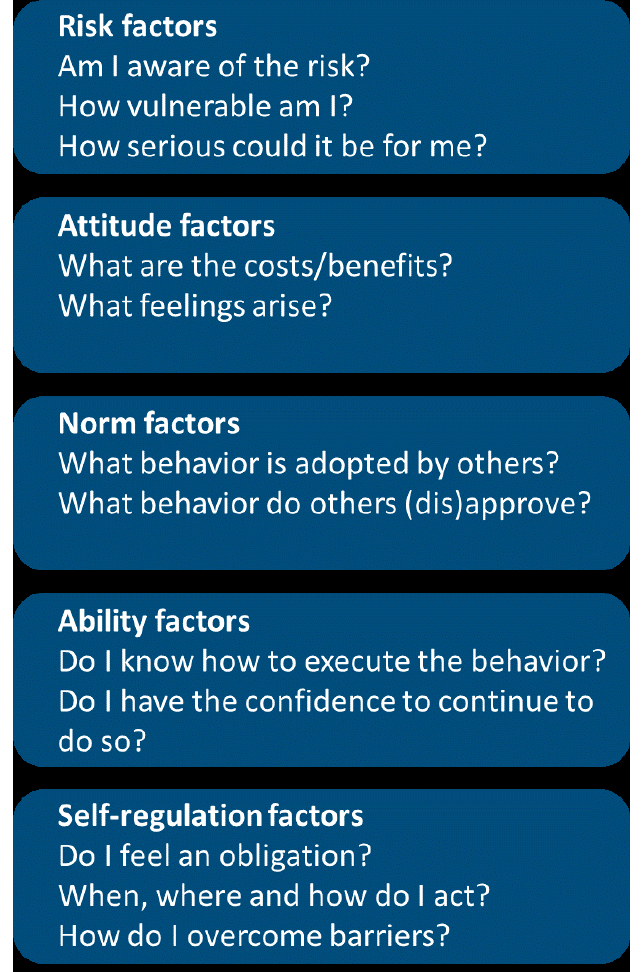
Figure 2. Five components of the RANAS model (https://www.ranasmosler.com/ranas).